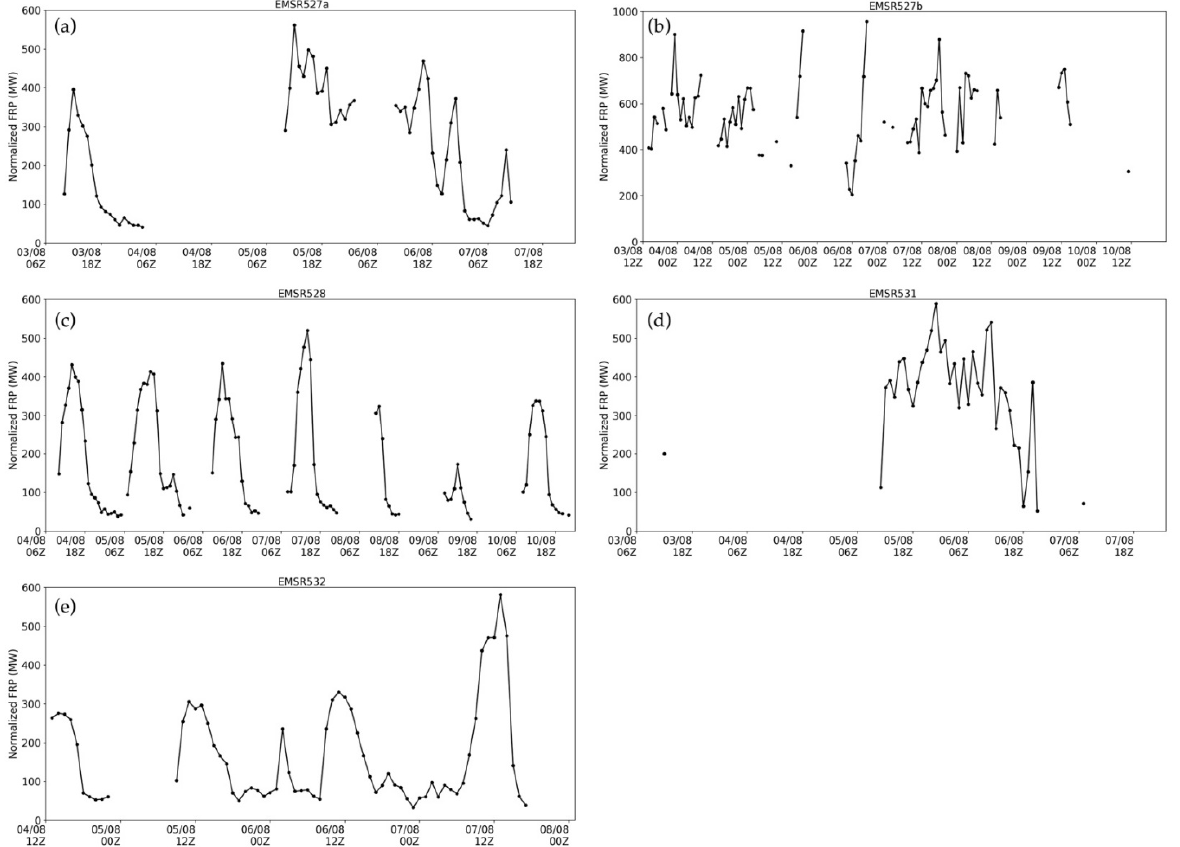
Figure 2. Time series of hourly normalized FRP from SEVIRI/METEOSAT: ( a ) EMSR527a, ( b ) EMSR527b, ( c ) EMSR528, ( d ) EMSR531, and ( e ) EMSR532. Note the differences in the vertical and horizontal axes’ scales.